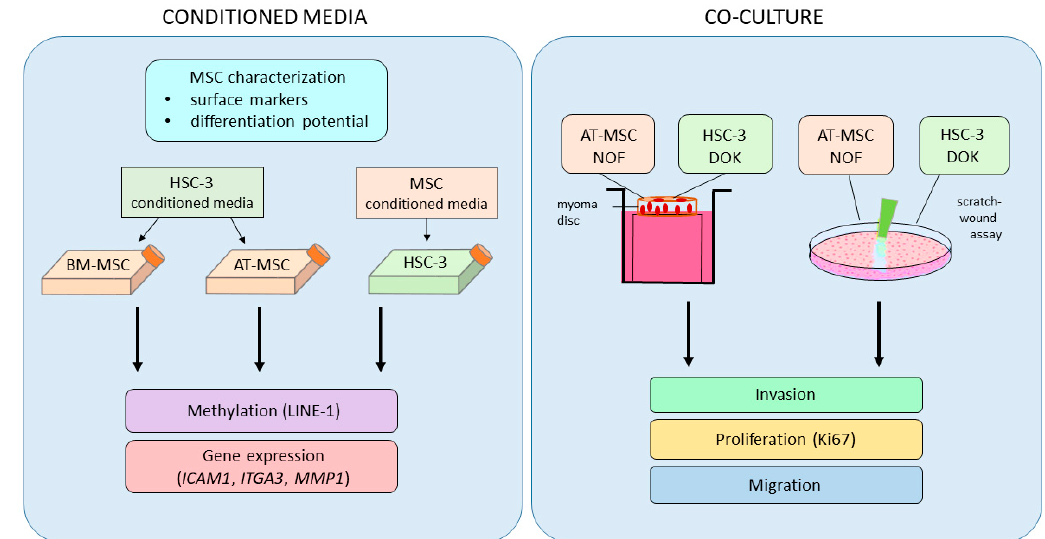
Figure 1. Study design workflow. Adipose tissue-derived mesenchymal stem cells (AT-MSCs) and bone marrow-derived mesenchymal stem cells (BM-MSCs) were first characterized and then used for conditioned media studies with human tongue squamous carcinoma (HSC-3) cells. Cells growing in conditioned media were analyzed for long interspersed nuclear element-1 (LINE-1) methylation and changes in expression of microenvironment remodeling genes. AT-MSCs, HSC-3 cells, dysplastic oral keratinocyte (DOK) cells, and normal oral fibroblasts (NOFs) were used in a co-culture system for invasion, proliferation and migration